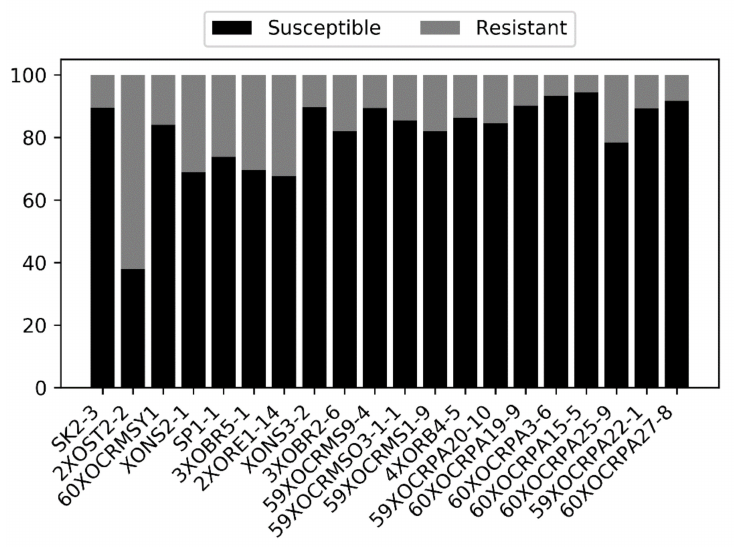
Figure 1. Percentage of susceptible versus resistant lines across 20 focal Xoo isolates (x-axis). Most rice accessions are predominantly susceptible to all but one Xoo isolate.